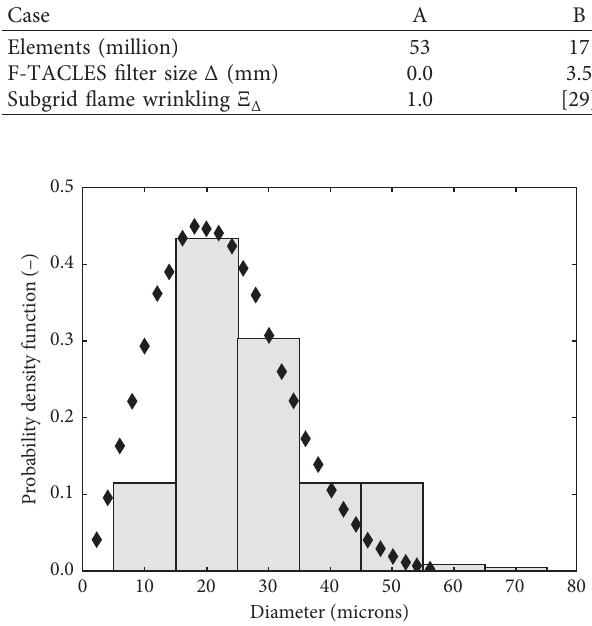
Figure 4: Particle size distribution. Experiments: grey bars, Ros- in–Rammler distribution: black diamonds.